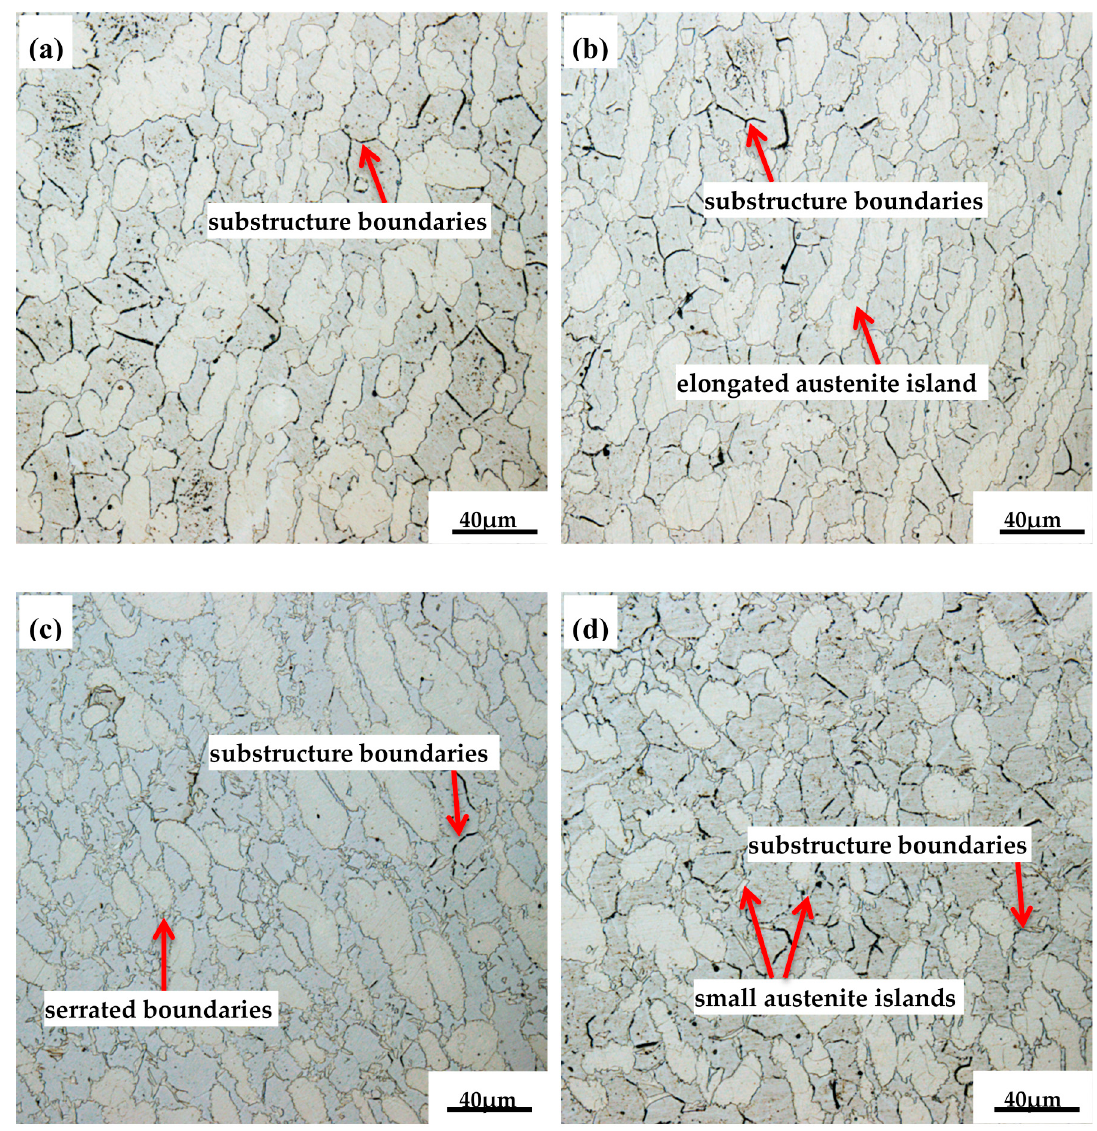
Figure 7. Microstructures of 2707 HDSS deformed at 1250 °C and different strain rates: ( a ) 0.01 s − 1 ; ( b ) 0.1 s − 1 ; ( c ) 1 s − 1 ; ( d ) 10 s − 1 .